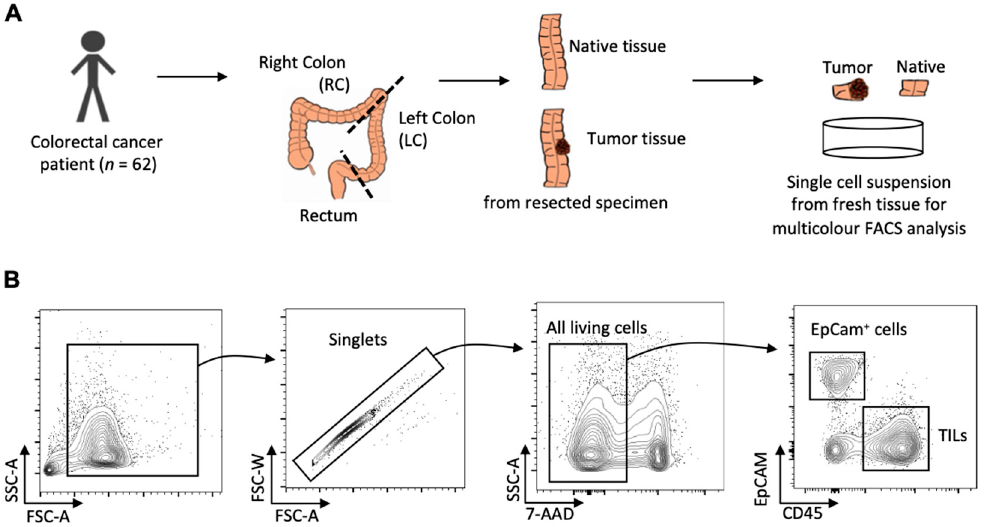
Figure 4. A flowchart summarizing the workflow of the study ( A ); gating strategy for identifying EpCam + cells and tumor-infiltrating leucocytes (TILs) ( B ).